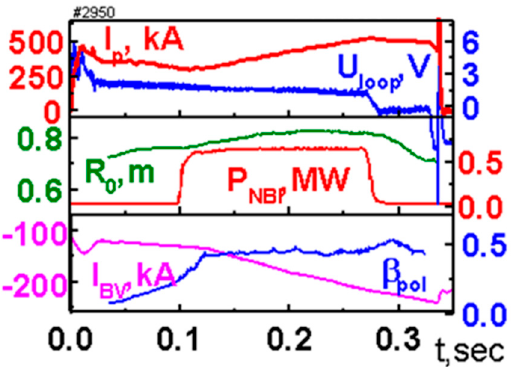
Figure 1. Plasma current ramp-up by B v ramp-up on MAST [23] at constant solenoid applied loop voltage: I p -plasma current, U loop -loop voltage, R 0 -plasma geometric axis, P NBI -NBI power, I BV -vertical field coil current, and β pol -poloidal beta.